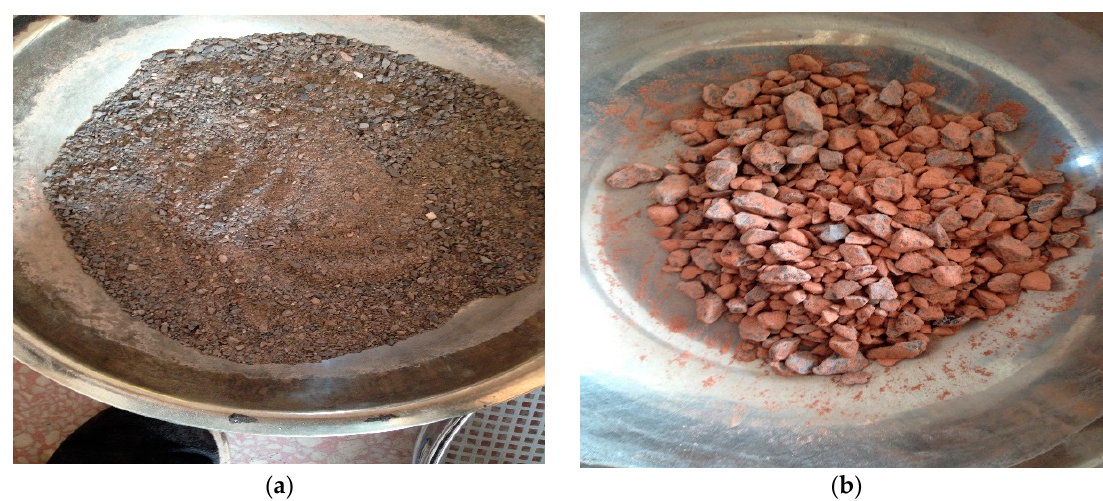
Figure 3. Aggregates with silt. ( a ) Fine aggregate with silt; ( b ) Coarse aggregate with